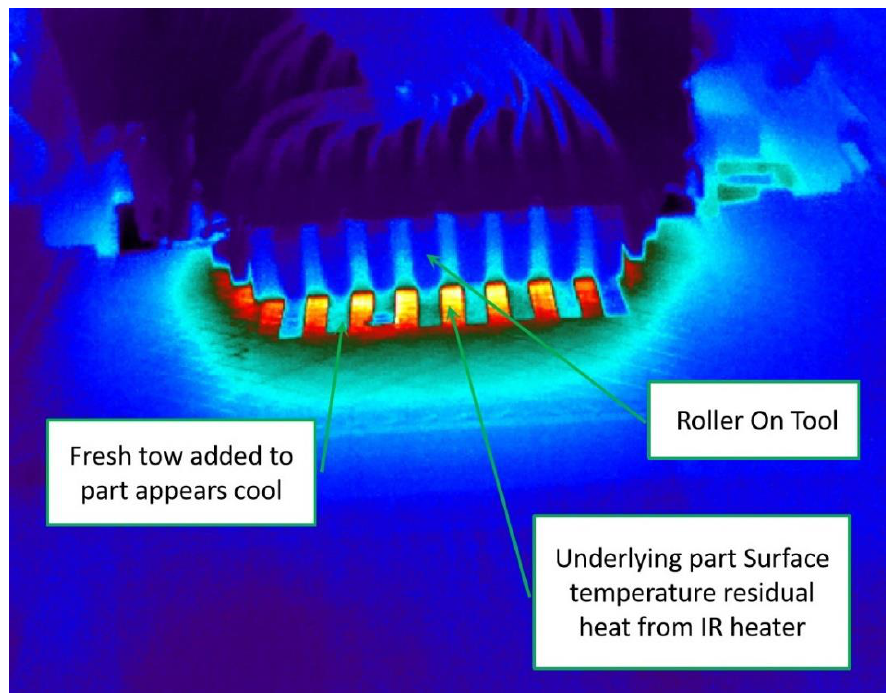
Figure 10. Infrared image of laying temperature test.